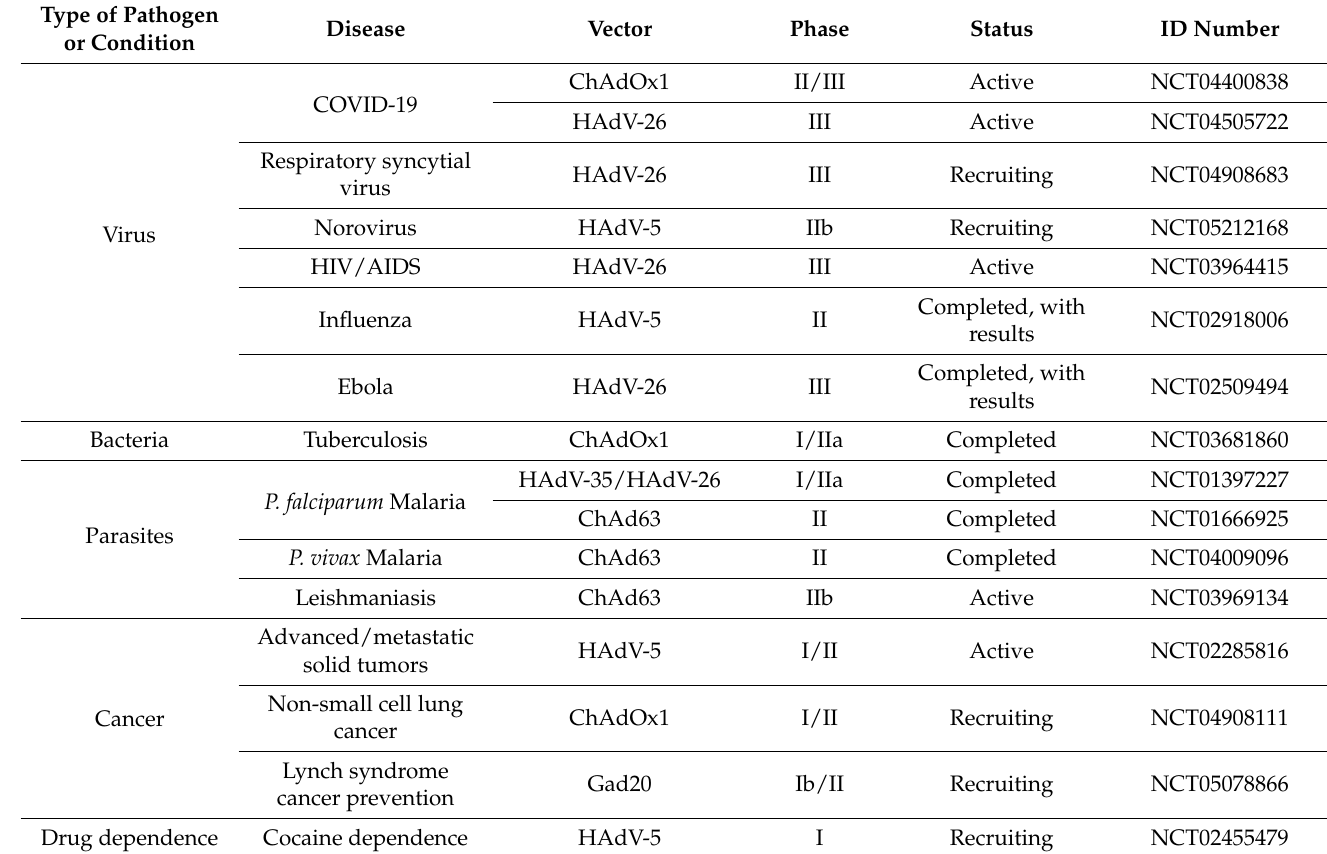
Table 1. AdV-vectored vaccines in human clinical trials. This list is